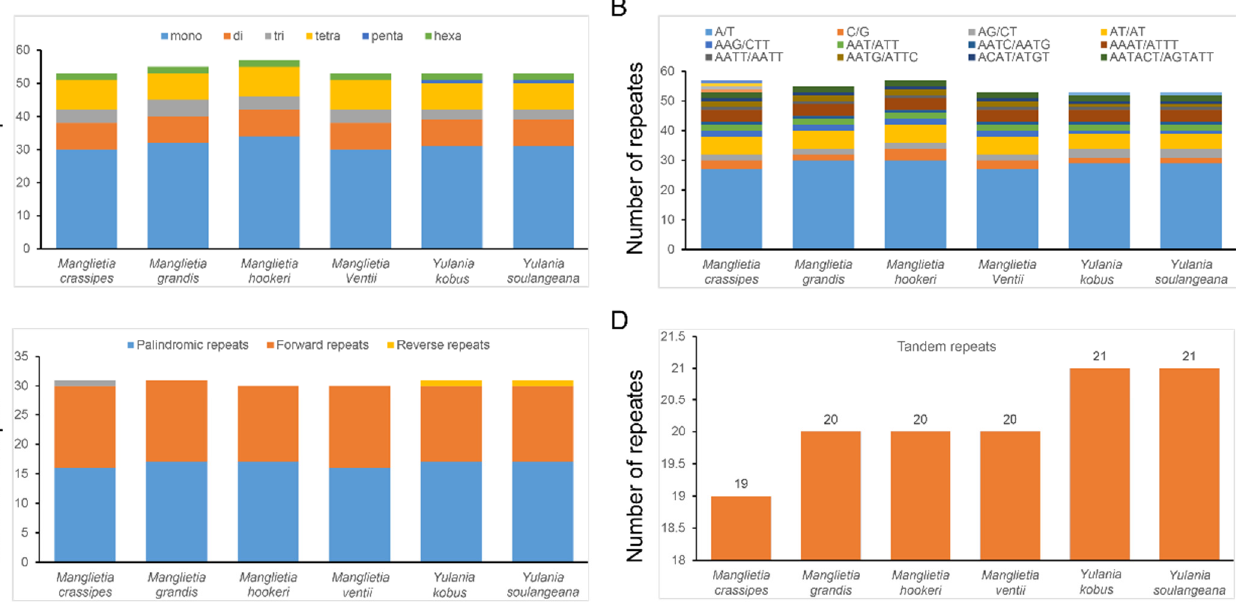
Figure 5. Comparison of repeats in six species of Magnoliaceae family. Note: ( A ) The type frequency of different SSR types. ( B ) The type frequency of SSR motifs in different repeat class types. ( C ) The type frequency of different repeat types. ( D ) The type frequency of dispersed repeat sequences.